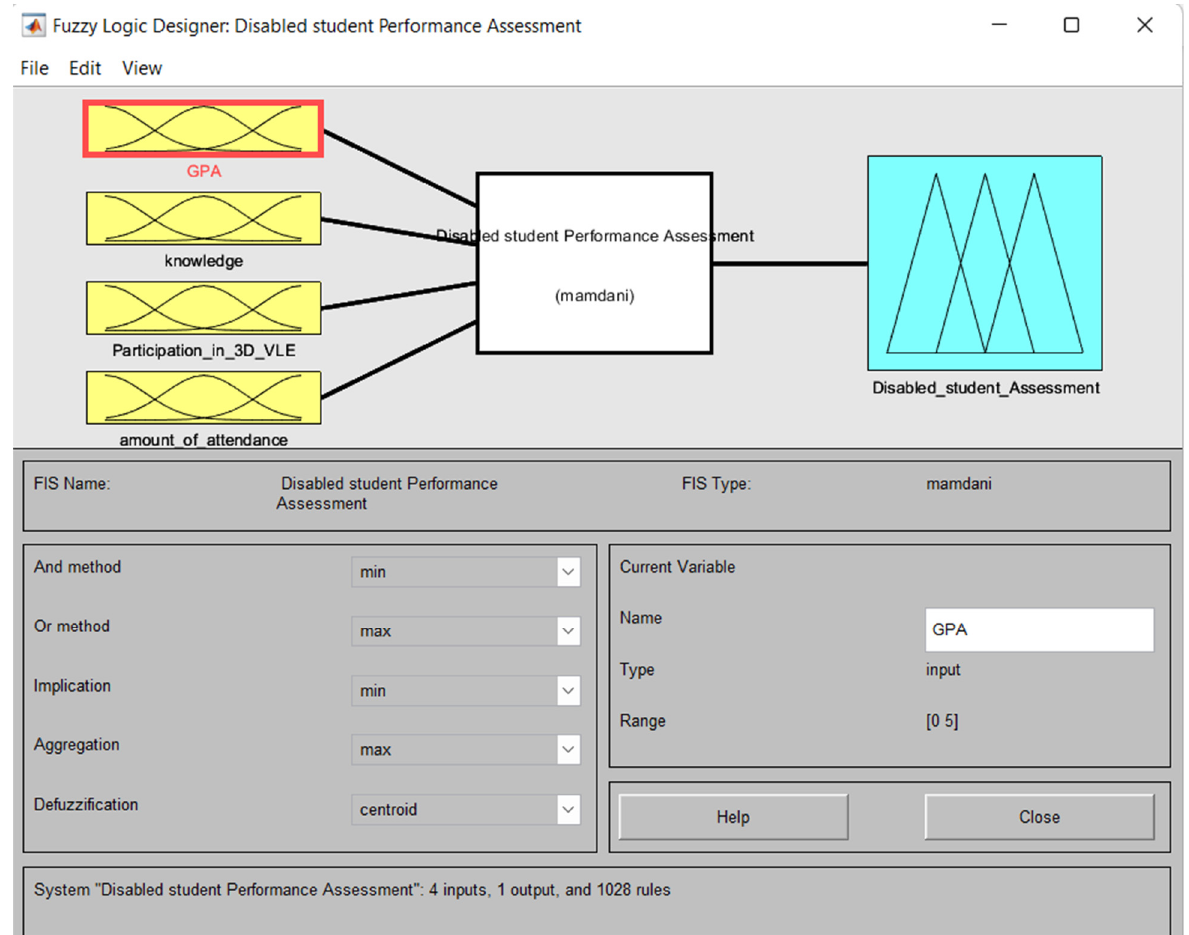
Figure 5. A Fuzzy Inference System.